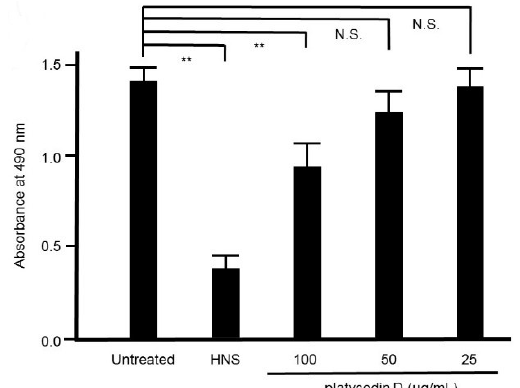
Figure 10. Inhibitory e ff ects of platycodin D on the biofilm formation by S. mutans . S. mutans were treated with platycodin D for 48 h, and stained with safranin red. Data show the mean ± S.D. ( n = 3). **: p < 0.01 by Tukey’s multiple comparison tests. NS: not significant.